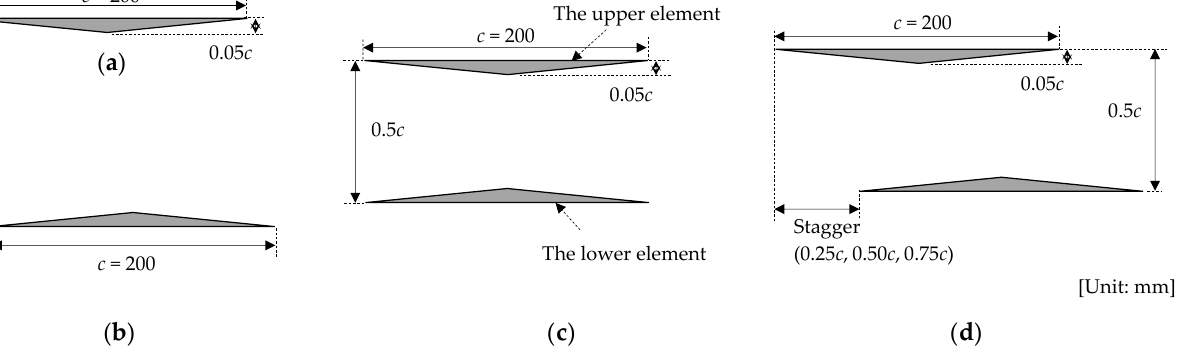
Figure 3. Experimental models: ( a ) single upper element; ( b ) single lower element; ( c ) baseline model (Busemann biplane — no stagger); ( d ) staggered models (three stagger lengths).